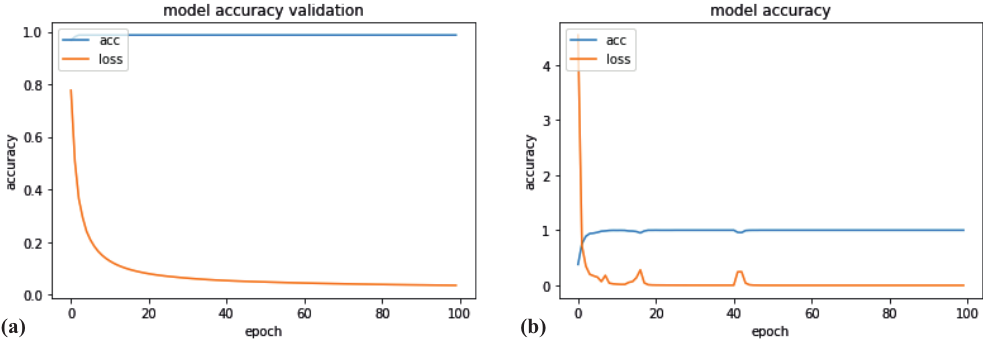
Figure 6. ( a ) Normal and ( b ) irregular dependencies of accuracy and loss on